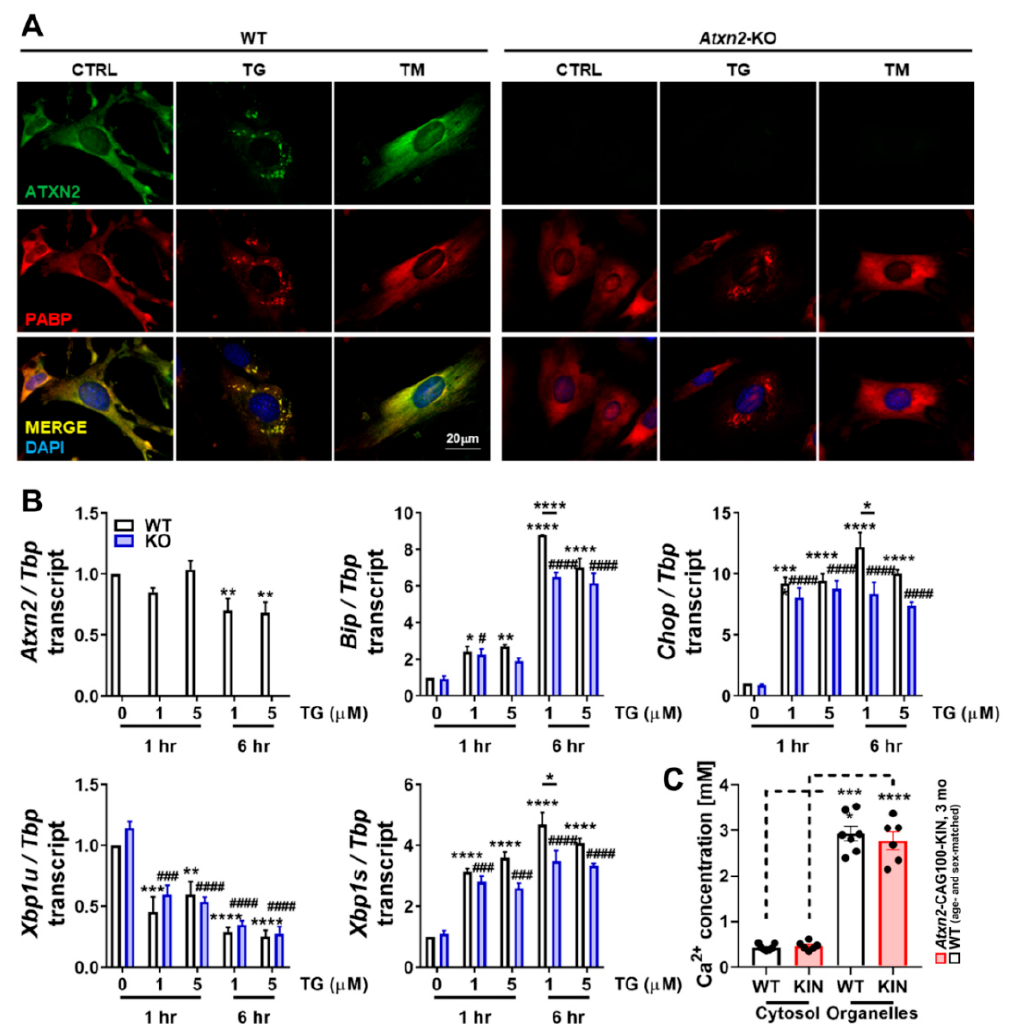
Figure 3. The effect of subcellular Ca 2+ imbalance on ATXN2 localization and expression in mouse embryonal fibroblasts. ( A ) Immunocytochemical assessment of ATXN2 and SG marker PABP in WT and Atxn2 -KO MEFs under thapsigargin-(TG, 5 μ M, 6 h) or tunicamycin-induced (TM, 10 μ g/mL, 6 h) ER stress. ATXN2 relocalization into PABP-positive SGs was observed, solely upon cytosolic Ca 2+ imbalance driven by TG, but not upon blockage of N-glycosylation by TM. Atxn2 -KO MEFs did not show a difference in SG formation upon TG treatment. ( B ) Transcriptional regulation of Atxn2 and ER stress markers under TG treatment, in a time- and dosage-dependent setup. Three different clones of WT and Atxn2 -KO MEF pairs were treated simultaneously with 1 μ M or 5 μ M TG for 1 h or 6 h. Stress response was already visible at 1 h for both TG dosages, and further increased at 6 h. While Atxn2 showed a significant downregulation under TG treatment, ER stress markers Bip , Chop and Xbp1s showed a suppressed induction in the absence of ATXN2 in KO cells (blue bars). Expression data obtained by RT-qPCR; ( C ) Colorimetric Ca 2+ concentration measurement in cytosolic and organelle-enriched fractions of WT and Atxn2 -CAG100-KIN cerebellum at three mo of age. Higher Ca 2+ concentrations were observed in the membrane-encapsulated organelle fraction with no difference between WT and KIN animals. Statistical assessment of the cell culture data was done using 2-way ANOVA with multiple testing corrections. Statistical assessment of the cerebellar Ca 2+ measurement was done using Student’s t -test with Welch’s correction; p < 0.05 *, p < 0.01 **, p < 0.001 ***, p < 0.0001 ****. Hashtag (#) indicates comparison of KO cells with untreated KO cells, with p < 0.05 #, p < 0.001 ###, p < 0.0001 ####. Further information regarding individual fold changes and p -values can be found in Supplementary Table